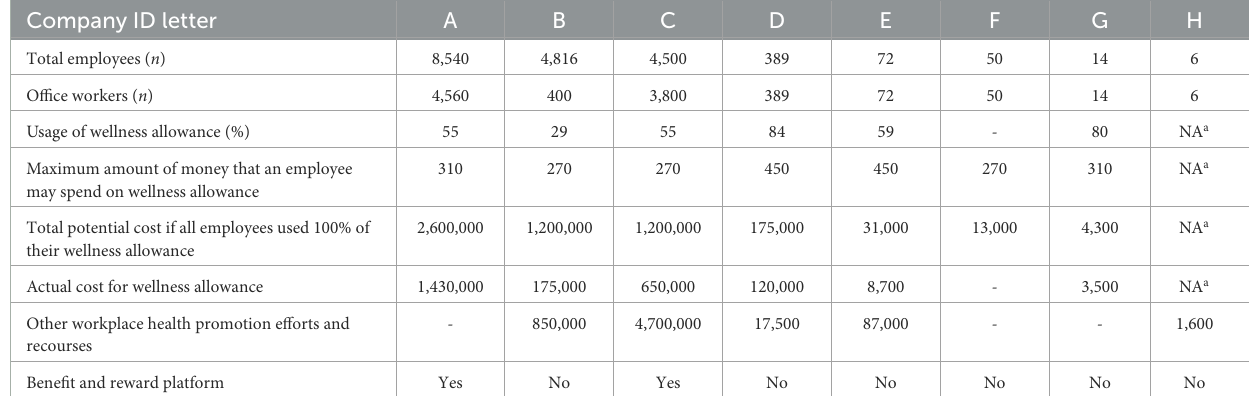
TABLE 2 Descriptive data of the total number of employees and the number of office workers at each company, respectively, as well as usage and costs for wellness allowance and other workplace health promotion for the whole company, regardless of type of work description, for the year of 2020 expressed in